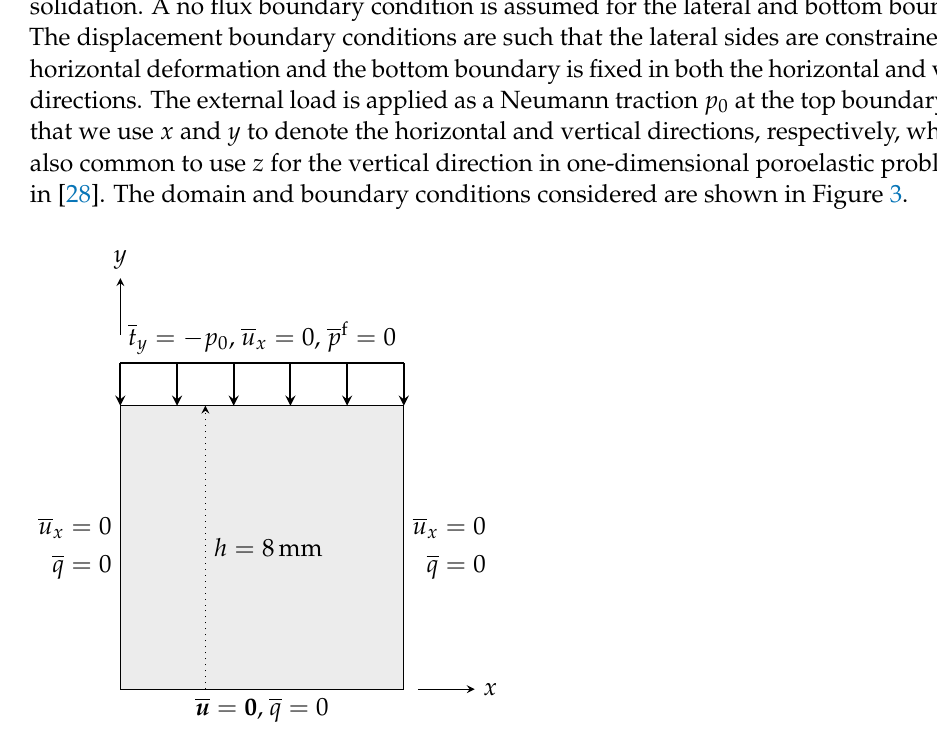
Figure 3. Terzaghi’s problem: Domain and boundary